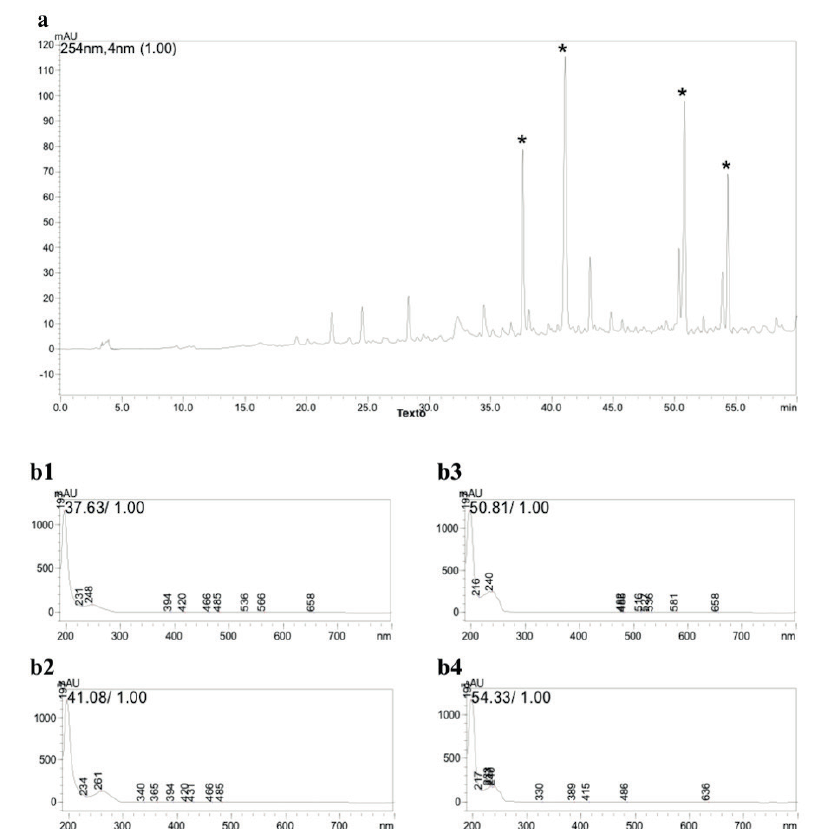
Figure 1. Phytochemical characterization of ethanolic bark extract of C. blanchetianus